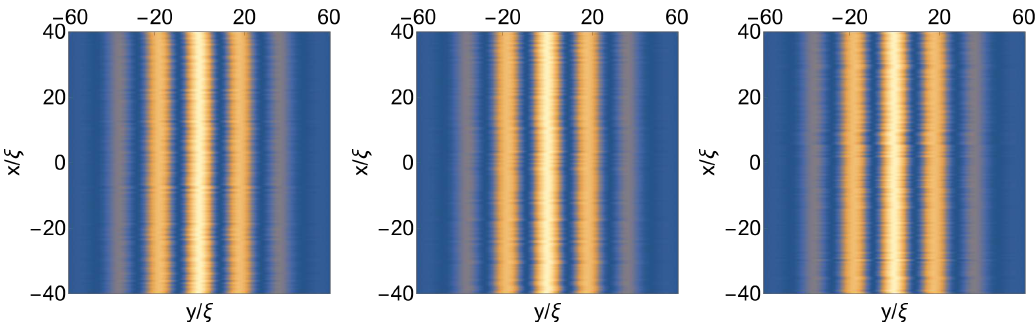
Figure 2: Samples of outcomes for individual (simultaneous) measurements of ( x , (cid:126) r , t + t ) at t = 0, using (49). In all density plots, outcomes are displayed ˆ ρ tof 1 0 0 at transverse coordinate (cid:126) r = ( y ,0 ) . The parameters are as presented in Section 5.3 = 16ms. and the time of flight is taken as t 1